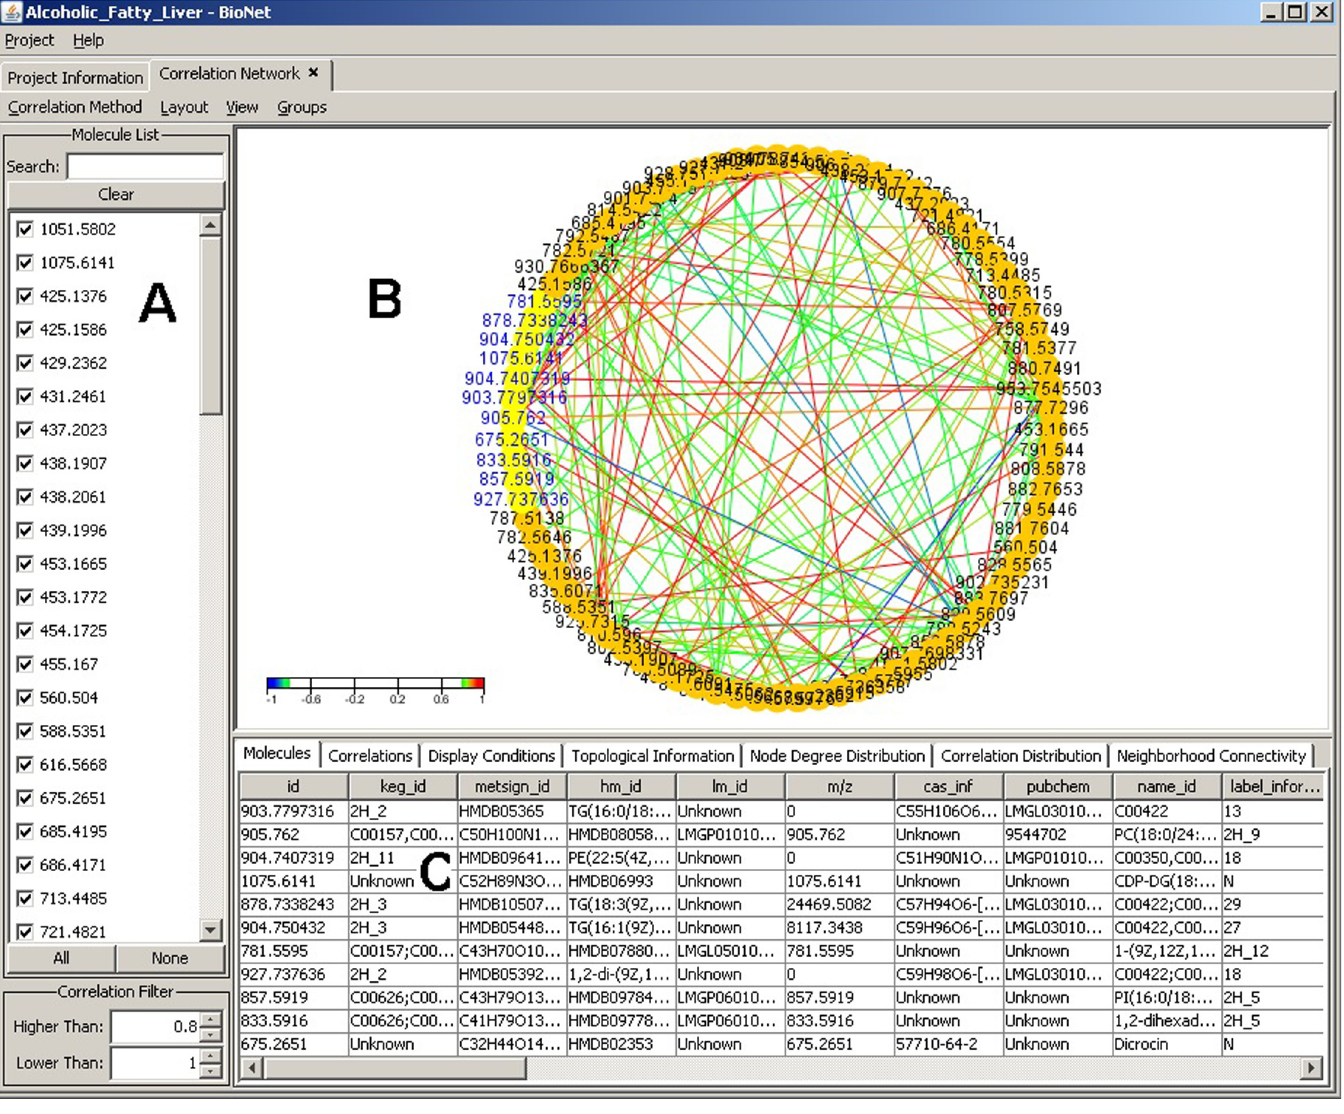
Fig 2. Correlation analysis window with single circle layout. (A) Molecular IDs. (B) Interactive graphic display of molecular correlations in a single circle display while applying the Pearson correlation calculation. (C) Information panel display for rich set of information about the selected (highlighted) molecules in the graph. Color scheme is used to show the correlation directions: red indicates positive correlation while blue indicates negative correlation. The encircled color areas readily demonstrate clusters of strong molecular correlation.